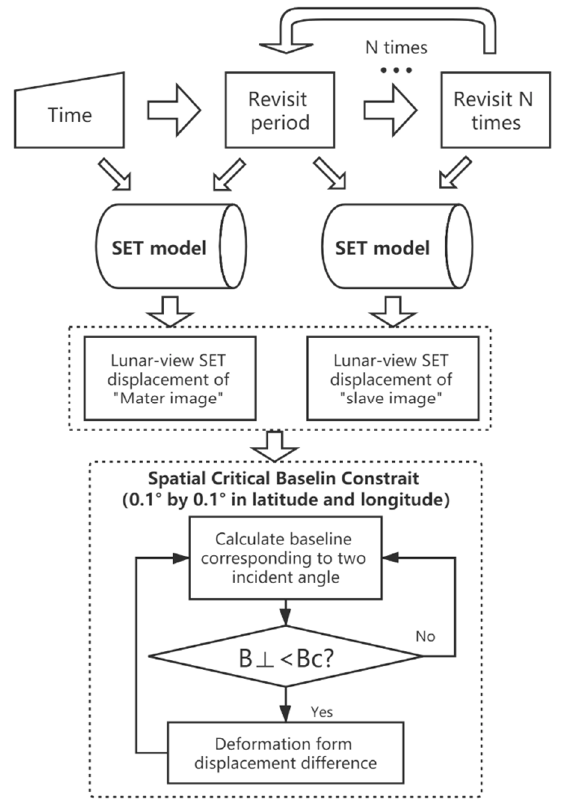
Figure 3. Flowchart of the calculation of the spatiotemporal baseline and SET deformation in the e ff ective interference region. The scanning trajectory of lunar synthetic aperture radar (SAR) is approximately parallel to the equator, as shown in Figure 6. The relationship between the longitude of lunar subpoint and accurate time point is established according to the ephemeris data. After inputting a start time of the master image, the revisit period can be determined. Additionally, the accurate time points of various longitudes as well as the start time of next scan can be calculated (assuming that the earth rotates at a constant speed). In this way, the displacement matrices under multiple revisits can be obtained by inputting longitude, latitude, and time point into the SET model. The vertical baseline ( B ⊥ ) matrix as well as the critical baseline ( B c ) matrix can be obtained via the ECEF coordinates of lunar center and the incident angle matrix (according to the lunar altitude angle matrix). The deformation matrices in e ff ective interference regions under multiple revisits can be obtained through the displacement matrices di ff erence and the critical baseline constraint ( B ⊥ < B c ) at every latitude and longitude.